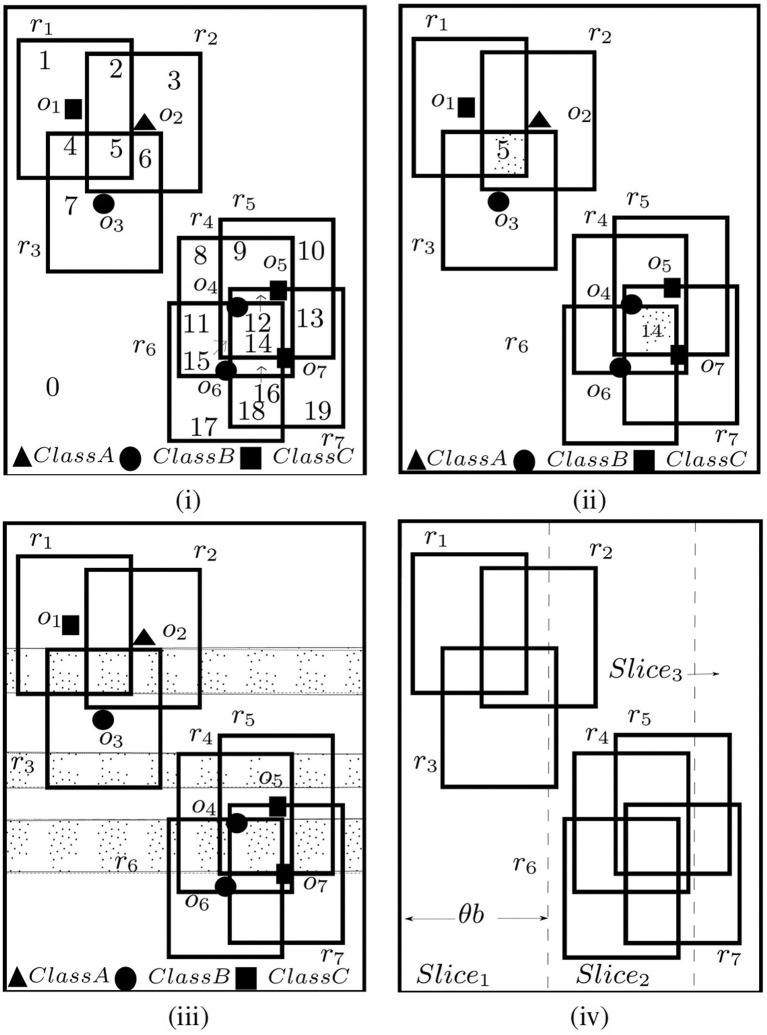
(i) Disjoint, (ii) Maximal regions, (iii) Maximal Slabs, and (iv) Slices.